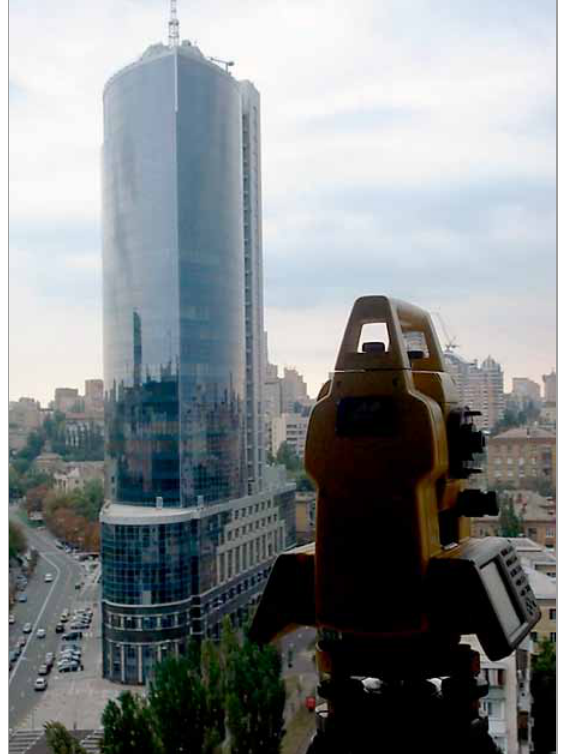
Fig. 2. Image of the research object – a